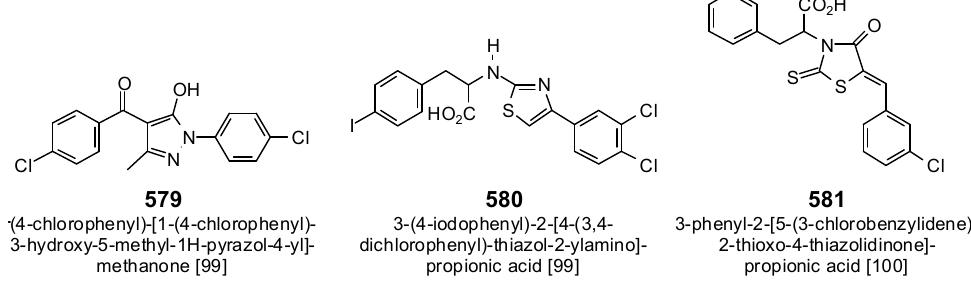
Figure 28. Structures of synthetic UDP ‐ galactopyranose mutase inhibitors.